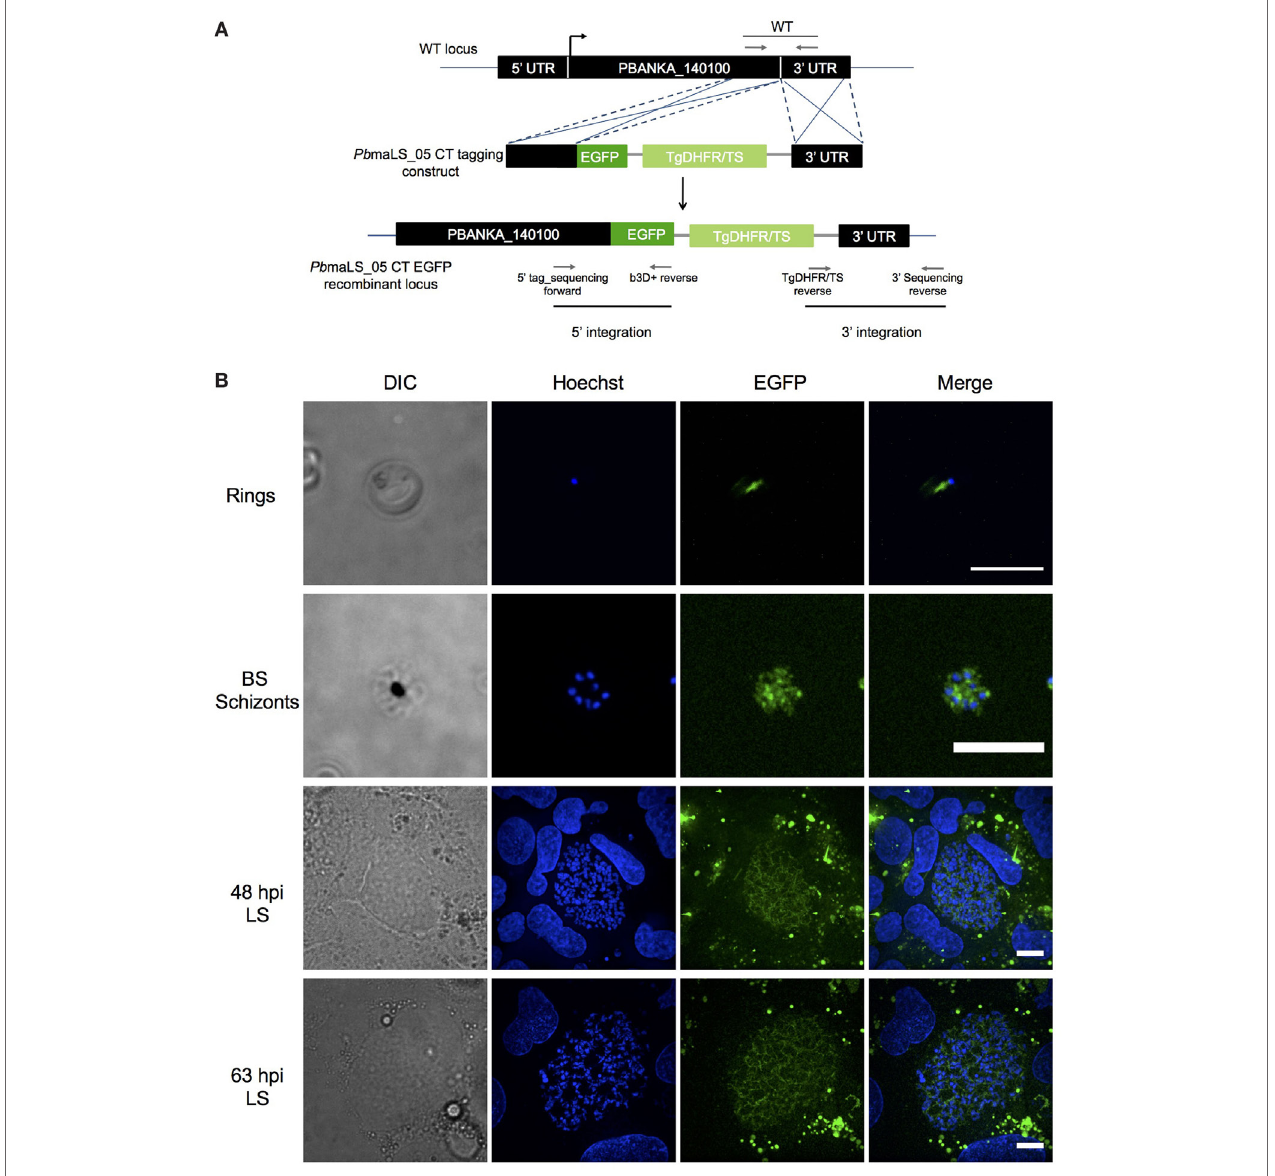
FigUre 1 | Pb maLS_05 is expressed in late liver- and blood-stage schizonts. (a) Pb maLS_05 EGFP parasites were generated by a double homologous crossover strategy that introduced a single EGFP tag at the C-terminal end of “ORF a.” (B) Pb maLS_05 is expressed in late blood- and liver-stages as observed by live imaging of Pb maLS_05 EGFP parasites under a spinning disk confocal microscope. The nuclei were stained with Hoechst. The images are representative of two independent experiments. Scale bar = 10